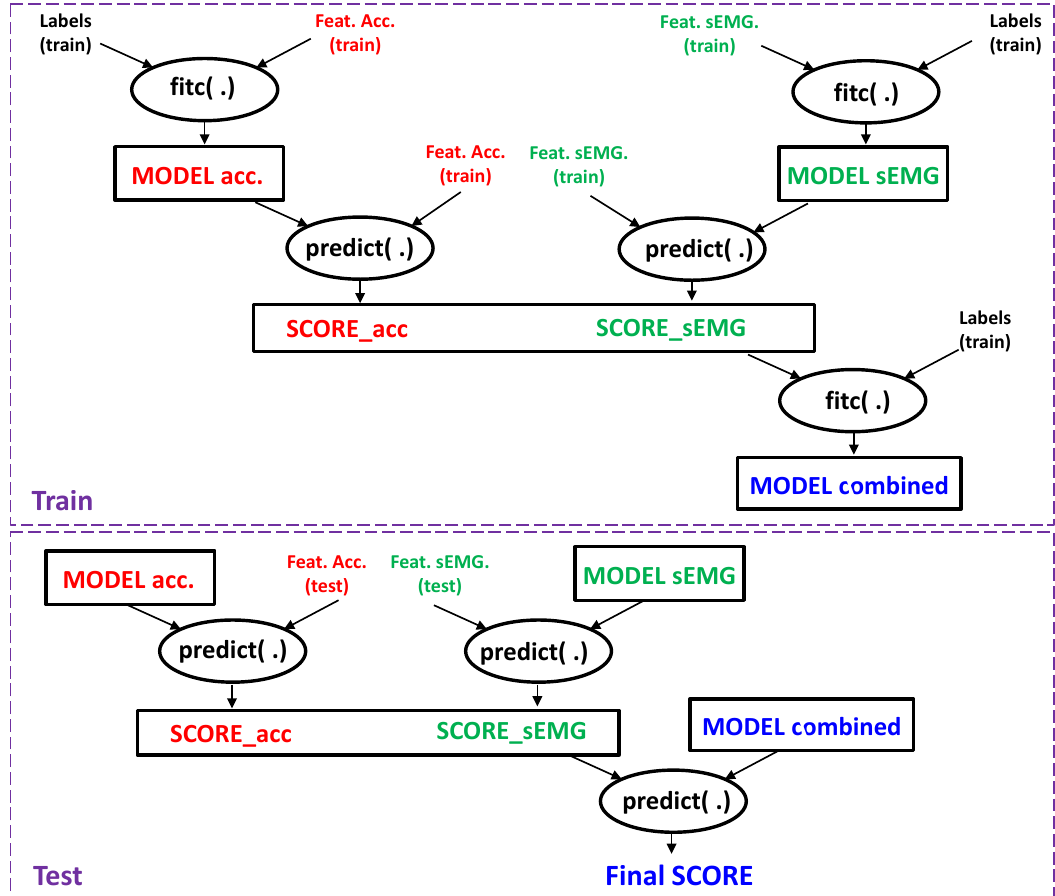
Figure 6. Classifier level fusion: flow of data and